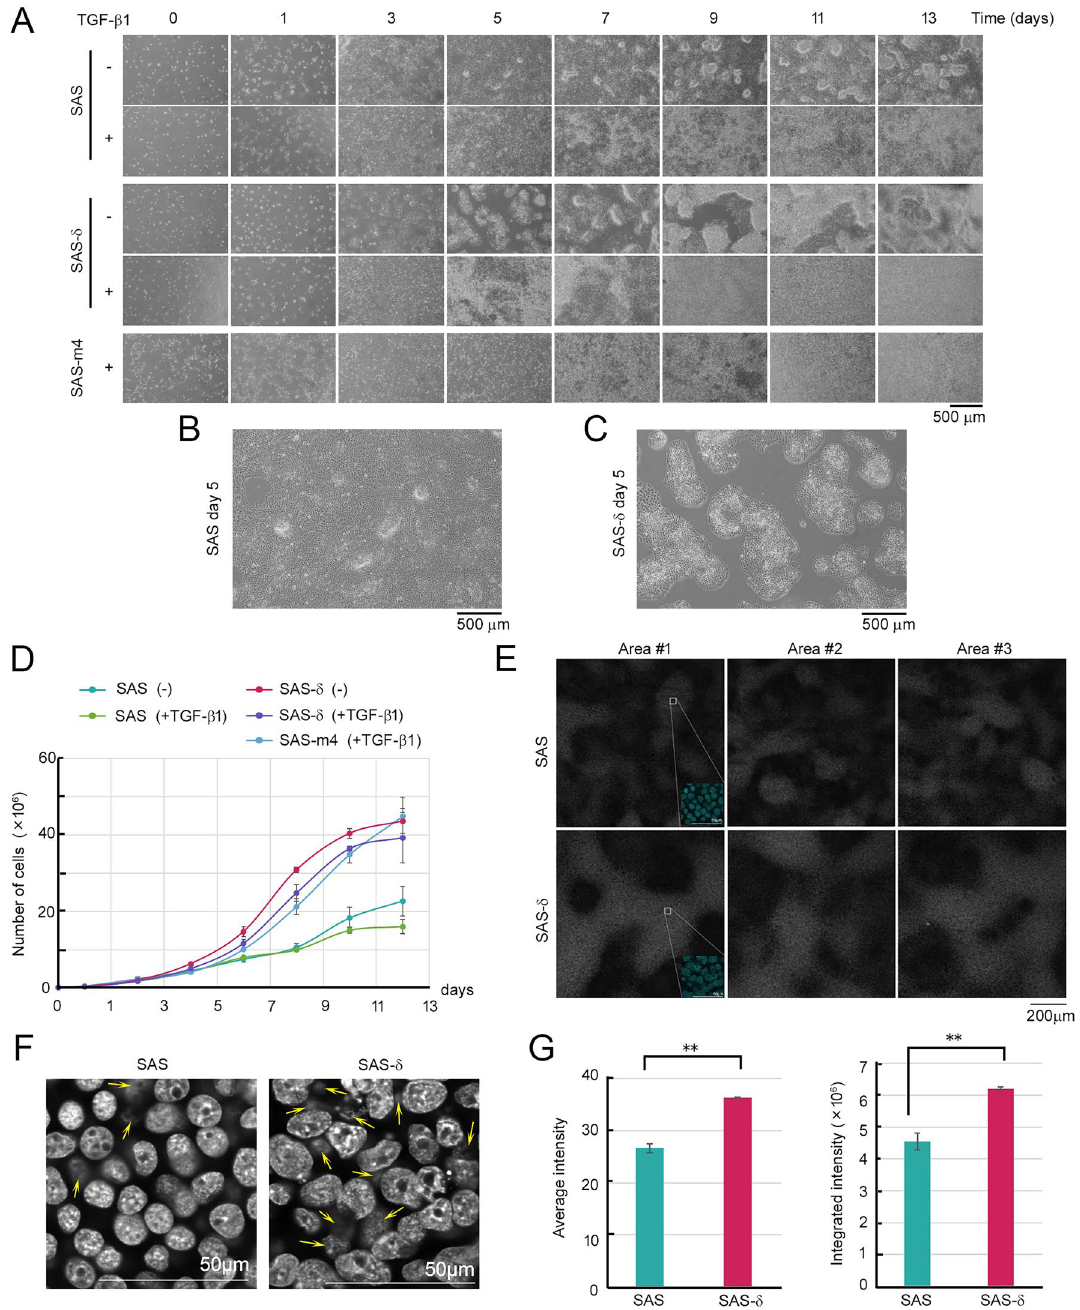
Figure 3. SAS-δ cells pile up and overgrow without cell–cell contact inhibition. ( A ) Parental SAS, SAS-δ, and SAS-m4 were treated with (+) or without (–)TGF-β1 (10 ng/ml) for the indicated numbers of days. Images were captured using a microscope. ( B ) and ( C ) The photograph digitally enlarged images of parental SAS ( B ) and SAS-δ ( C ) on day 5 in the absence of TGF-β1. ( D ) Growth curves of parental SAS, SAS-δ, and SAS-m4 in the presence (+) or absence (–) of TGF-β1. Cells were maintained as in ( A ). Data represent the average of cells from three independent experiments. ( E ) Visualization of the three-dimensional cell density of parental SAS and SAS- δ. A two-dimensional image was reconstructed from three dimensional stacks by superimposing the collected Z-series images of the stained nuclei (pale gray patches). Insets show enlarged color images of nuclei (blue). ( F ) The photograph digitally enlarged monochrome images of nuclei in ( E ). The photo images were focused on nuclei of cells in the upper layer. Yellow arrows indicate out-of-focus nuclei of cells grown in the lower layer, suggesting that the upper cells continuously grew and piled up. ( G ) Bar graphs show the average intensity (left) and integrated intensity (right) of nuclear signals in the reconstructed images (as in E ) of parental SAS and SAS- δ. Data represent the mean ± standard deviation from three independent areas. ** P <